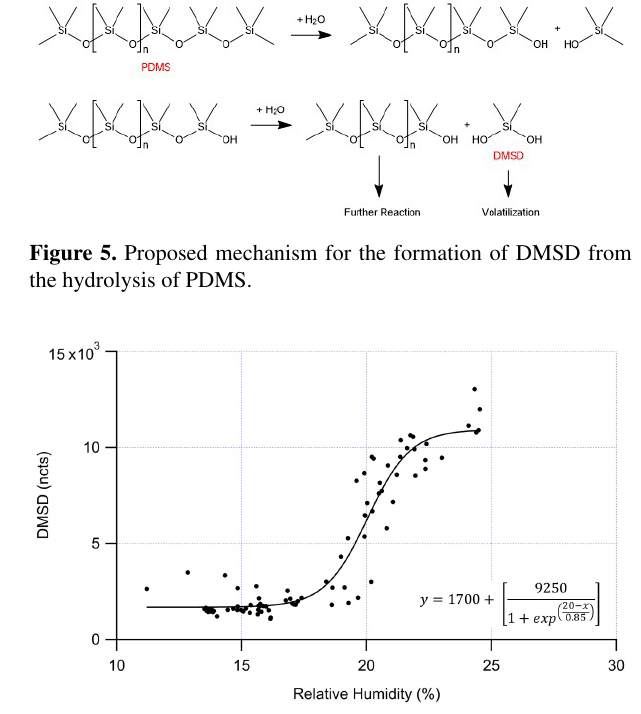
Figure 6. DMSD (normalized counts, ncts) measured by the GC-EI- TOF versus relative humidity (%). The data was fit with a sigmoidal curve that shows the greatest rate of change in DMSD production at ≈ 20%